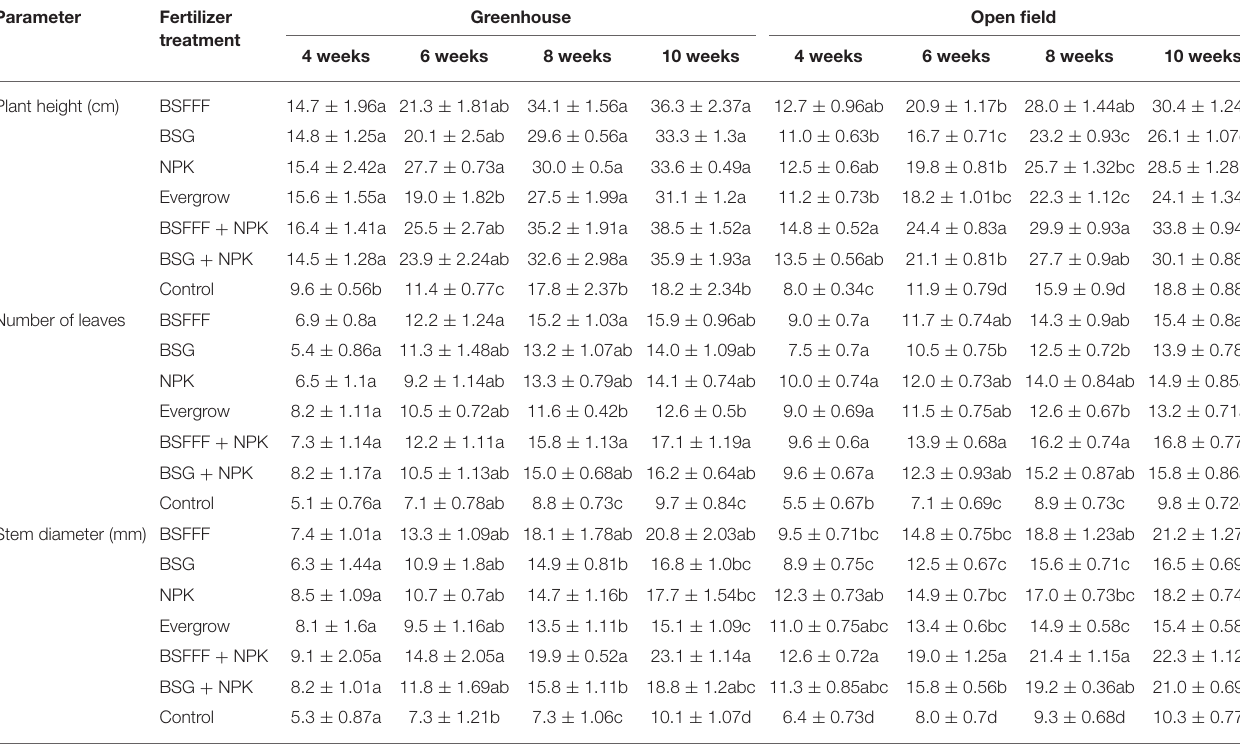
BSFFF, black soldier fly frass organic fertilizer applied at sole rate equivalent to 371kg N ha − 1 ; BSG, conventional compost from brewer’s spent grain applied at sole rate equivalent to 371kg N ha − 1 ; NPK, commercial mineral fertilizer applied at sole rate equivalent to 371kg N ha − 1 ; Evergrow, commercial organic fertilizer applied at sole rate equivalent to 371kg